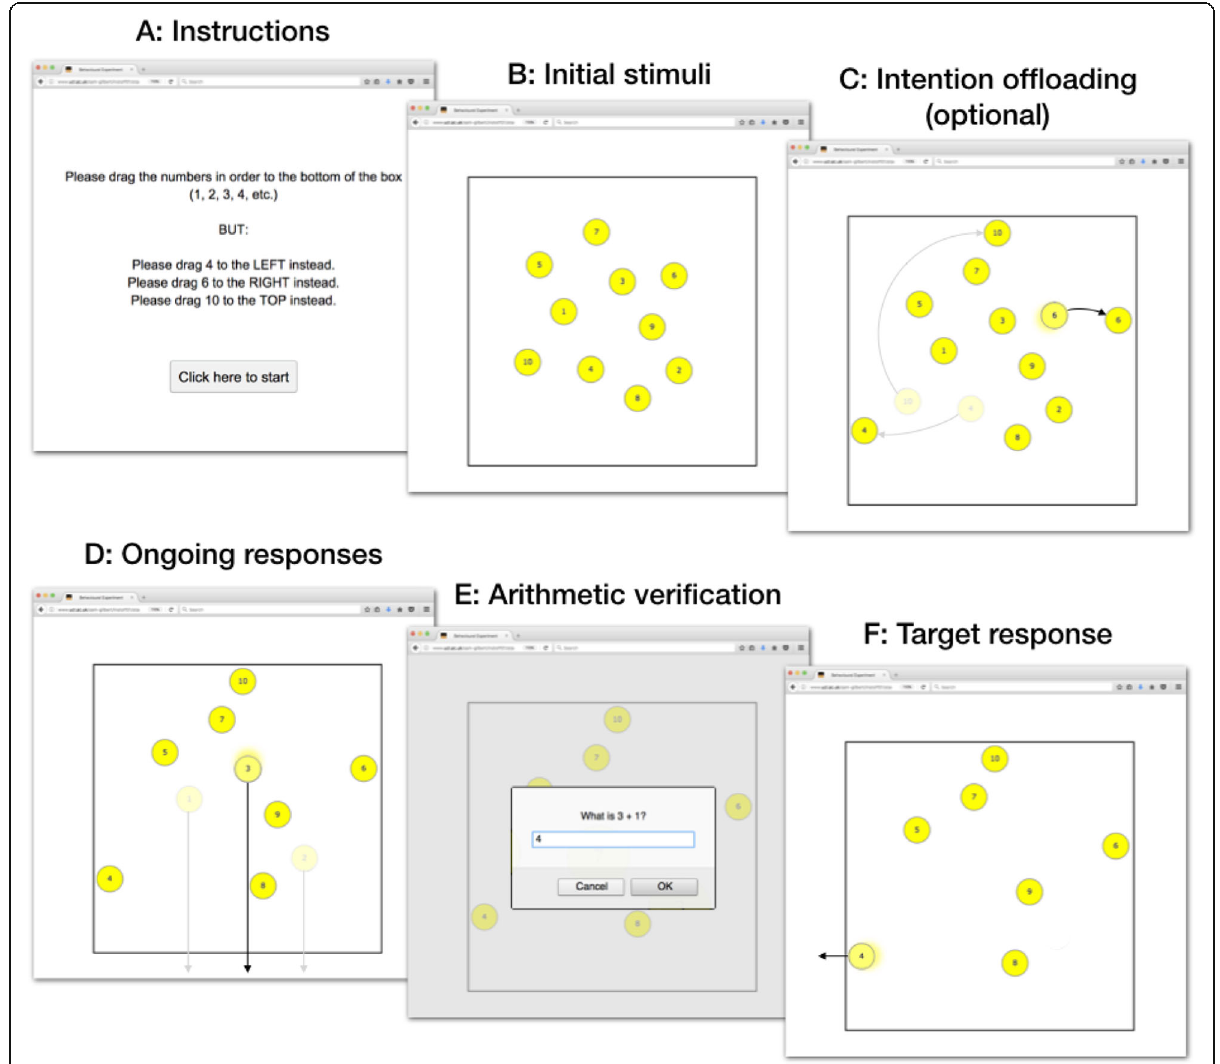
Fig. 1 Schematic illustration of the intention offloading task from a previous study (Gilbert, 2015a). Prior to each trial, participants were presented with an instruction ( a ), informing them about three target circles. They were then faced with 10, randomly arranged circles ( b ). In some phases of the task, people were free to set reminders by placing the target circles close to their instructed border ( c ). The main task was to move the circles out of the bottom of the square in numeric order ( d ). Before the first target circle was reached, an arithmetic verification task was presented ( e ). After submitting a response, participants continued with the next circle, in this example by moving the first target circle off the square ( f ). The trial ended once all circles had been